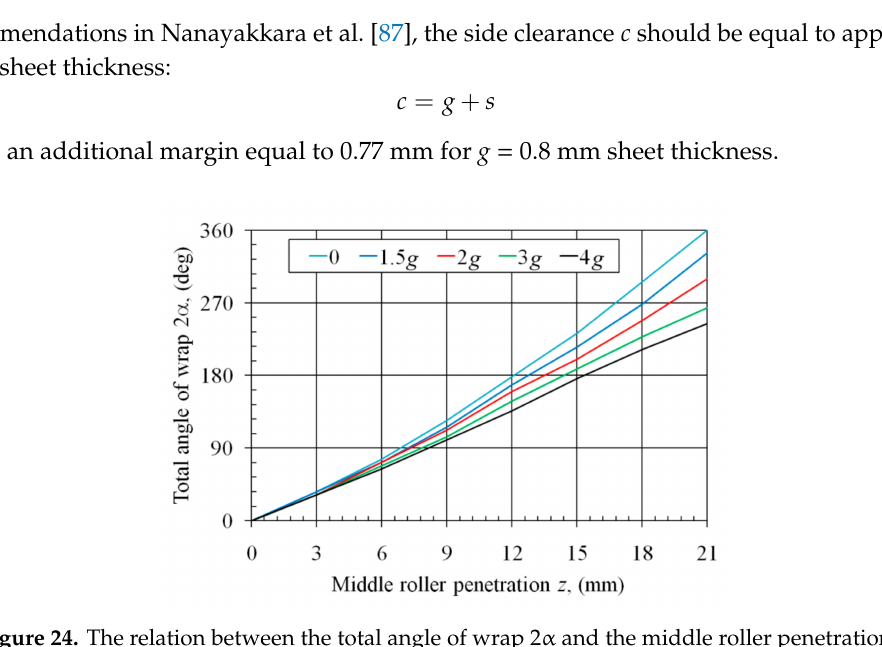
Figure 24. The relation between the total angle of wrap 2 α and the middle roller penetration